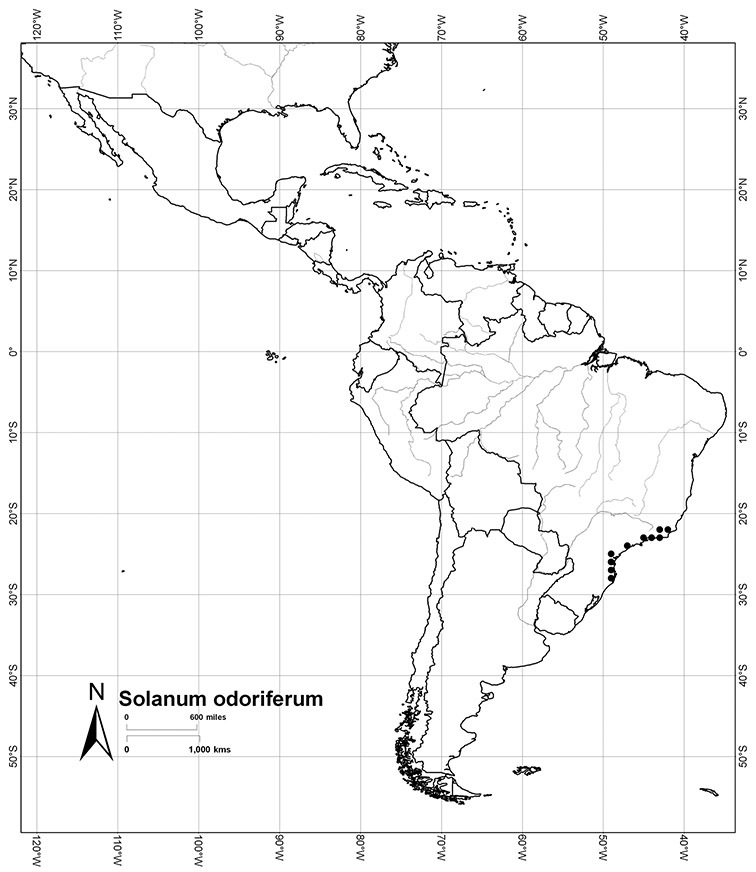
Distribution of Solanum odoriferum Vell.